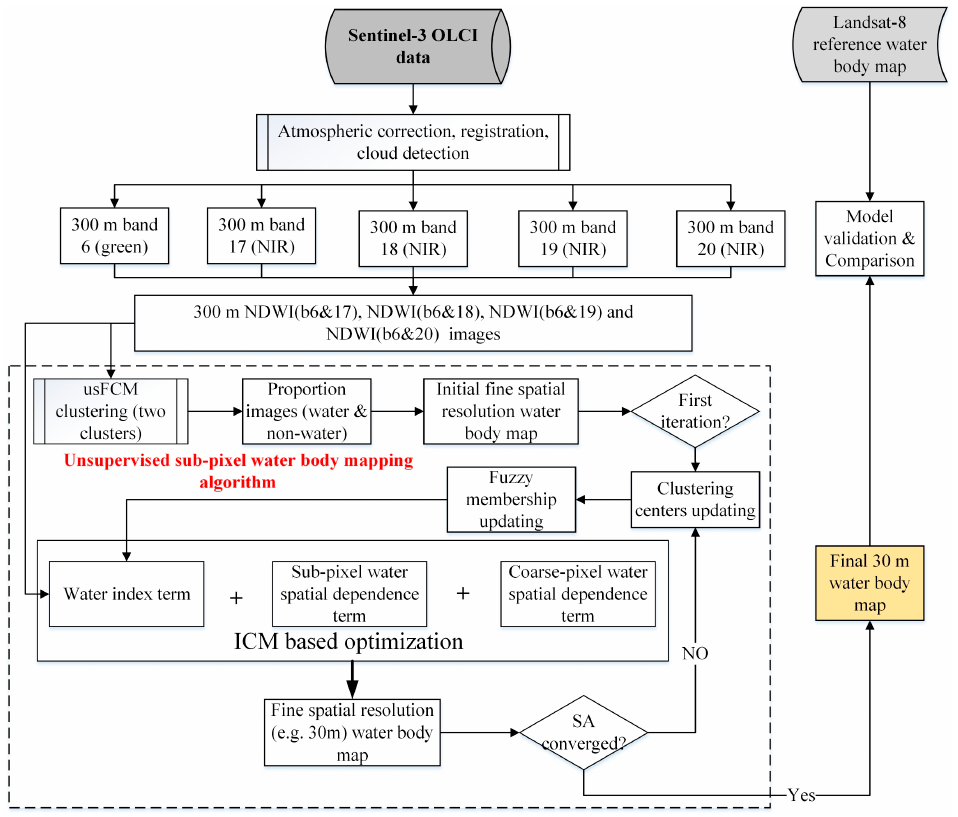
Figure 2. Flowchart of the proposed USWBM approach.